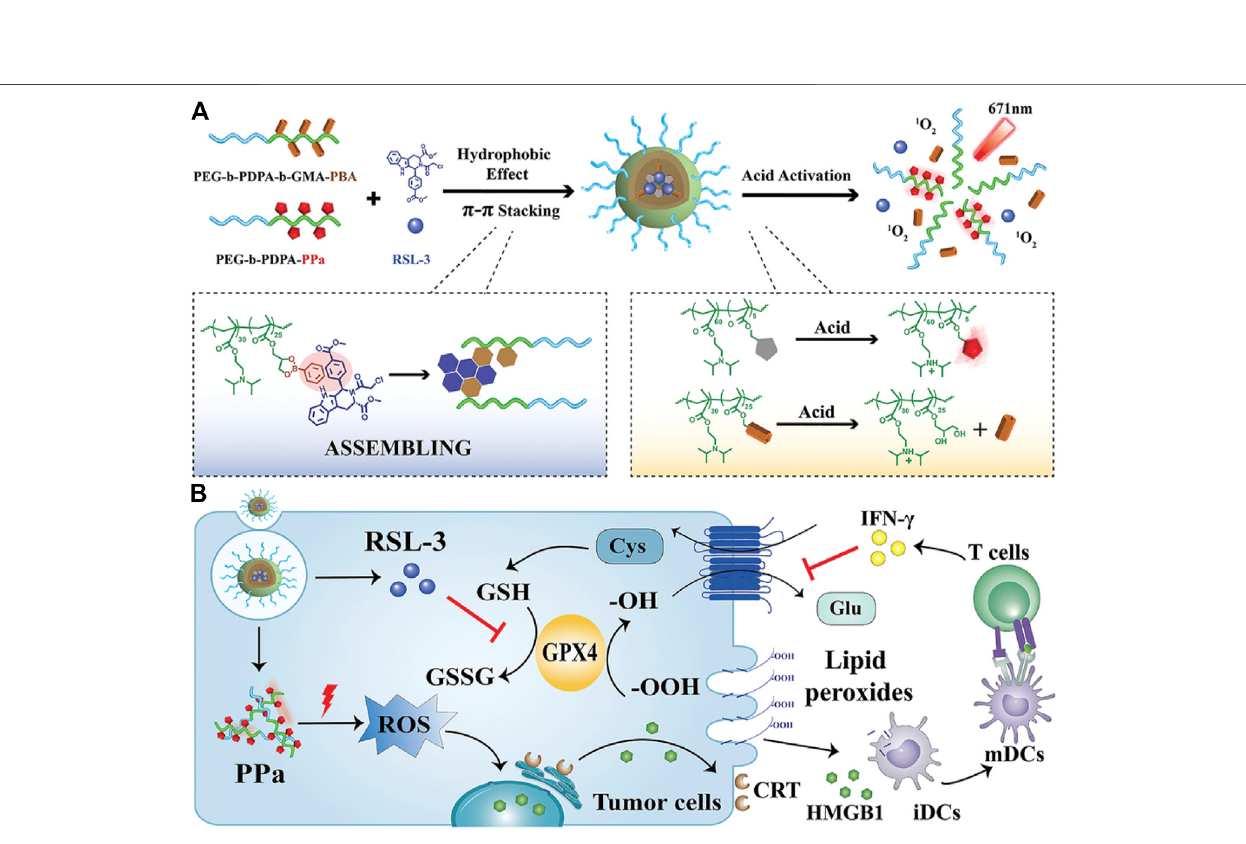
Frontiers in Chemistry |